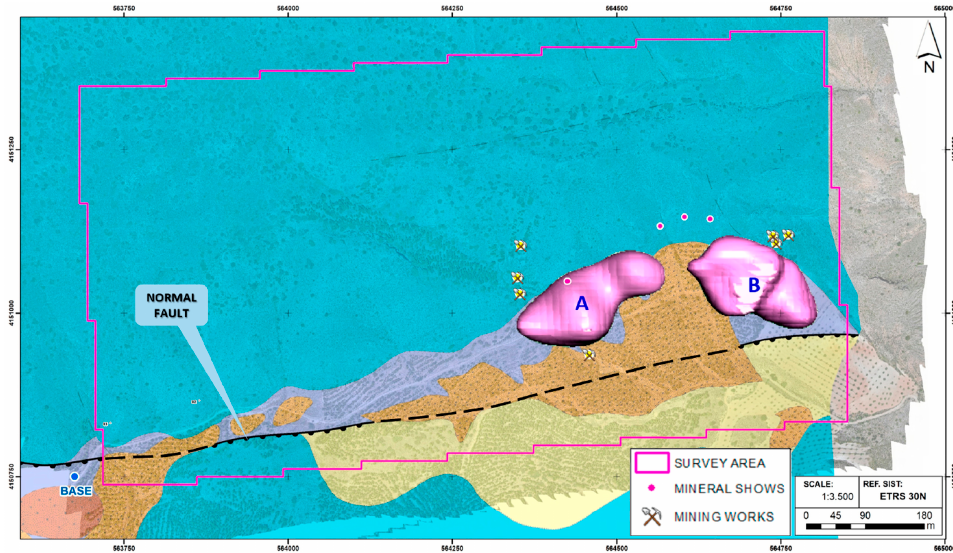
Figure 20. Three-dimensional model of the magnetic susceptibility of the Don Jacobo area, displaying the position of the two bodies of high magnetic susceptibility A and B; over the 1:5000 geological cartography and aerial RGB image of the area of Don Jacobo (Reprinted from Ref. [114]).